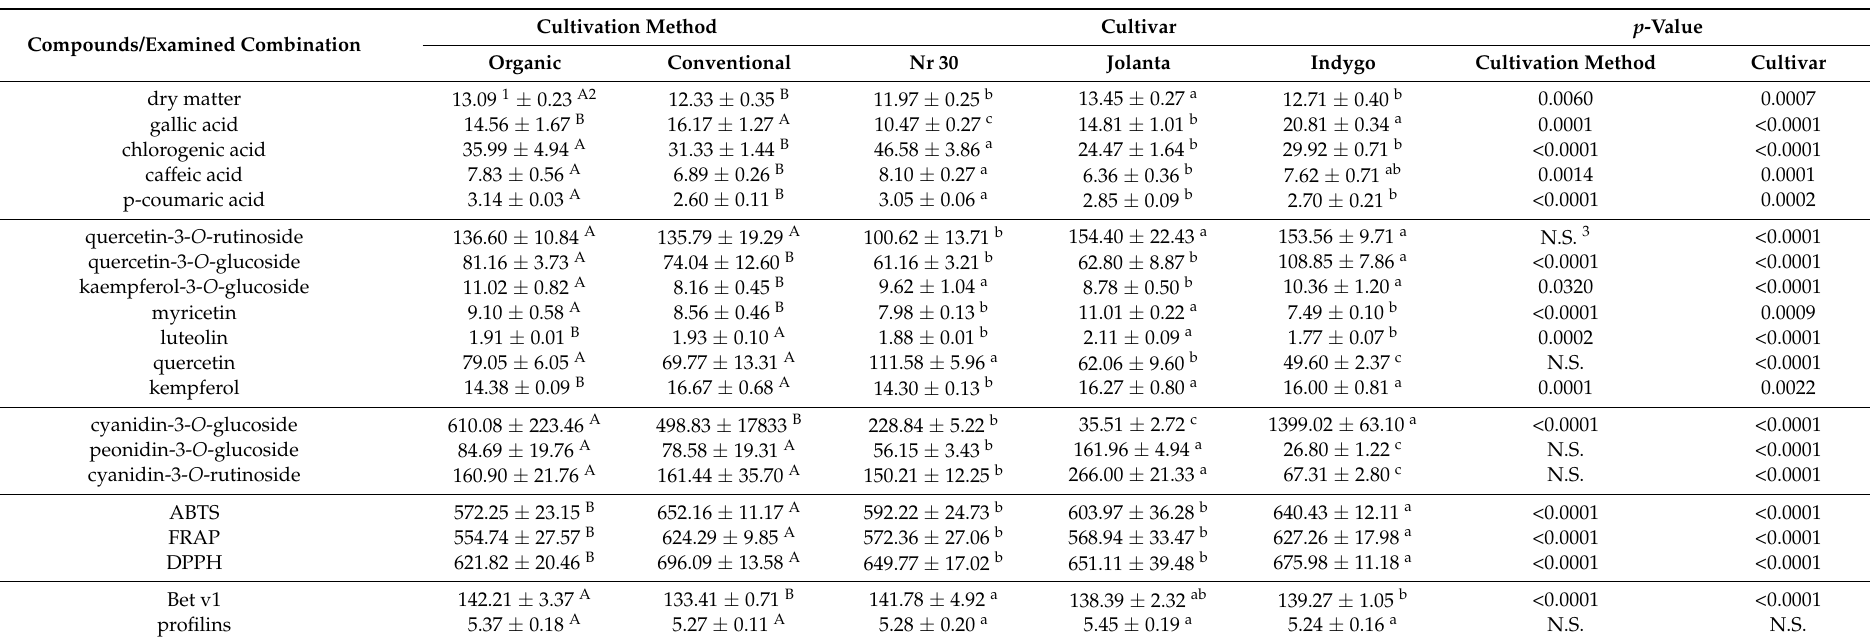
Table 3. The content of dry matter in (g 100 g − 1 F.W.), polyphenols (mg 100 g − 1 D.W.), antioxidant activity ( µ M TEAC g − 1 D.W.), Bet v1 (ng g − 1 D.W.) and profilins ( µ g g − 1 D.W.) in examined blue honeysuckle fruits in